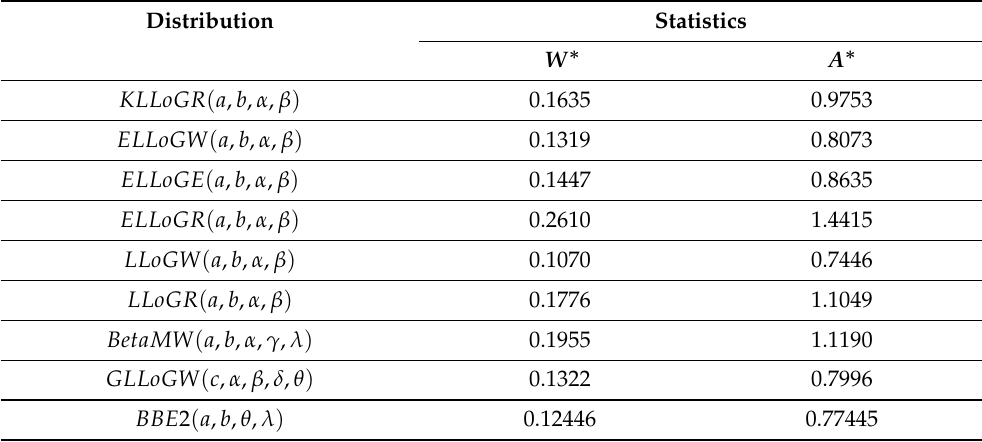
Table 16. Goodness-of-fit tests corresponding to the Stress-Rupture life of Kevlar 49/Epoxy Strands